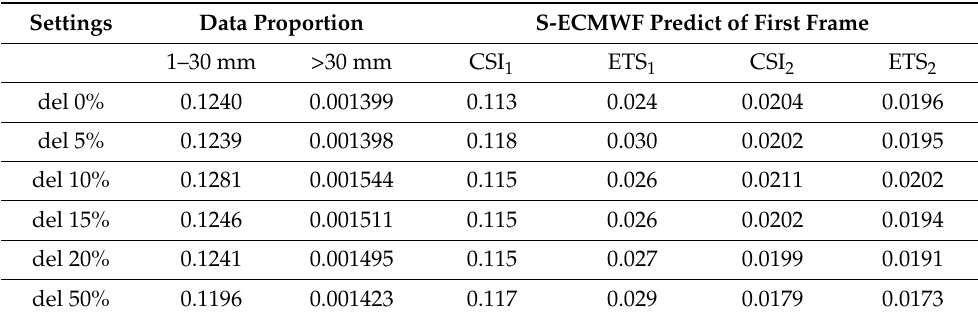
Table 7. Ablation experiment investigating the effect of low-rainfall sequence removal on the perfor- mance of the HDGN model.